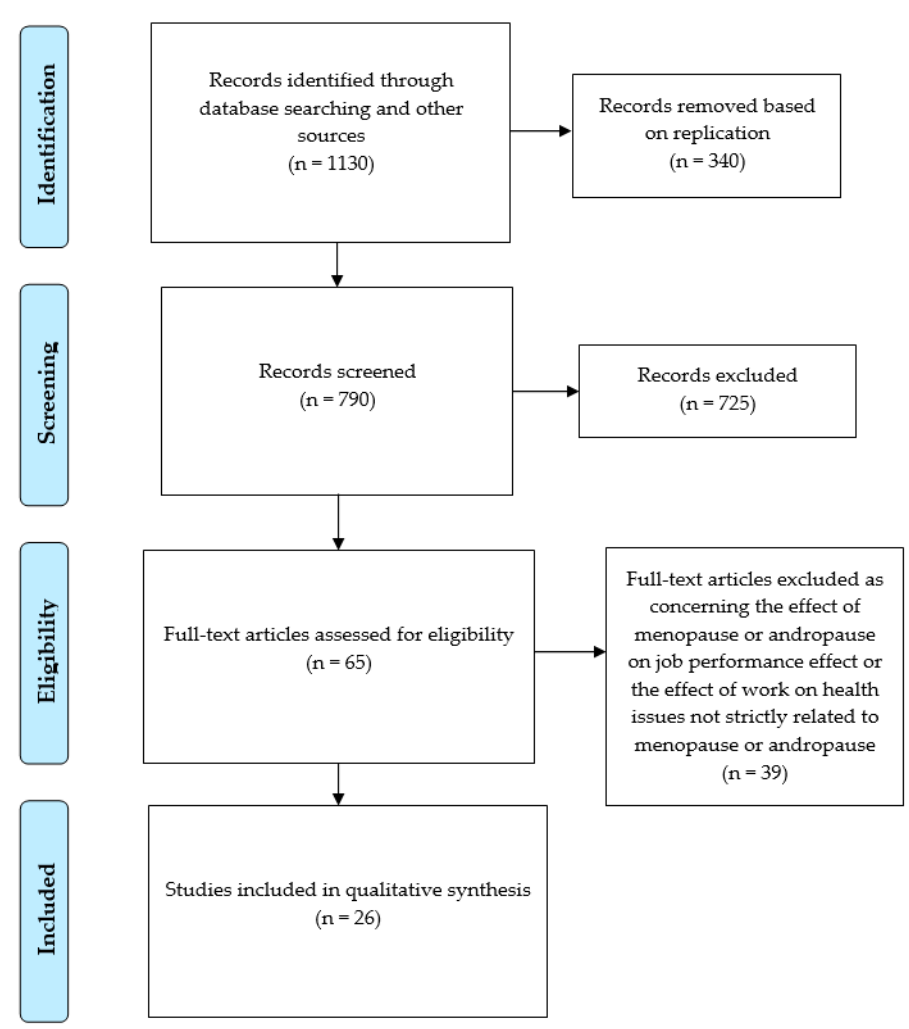
Figure 1. PRISMA flow diagram of the literature search.